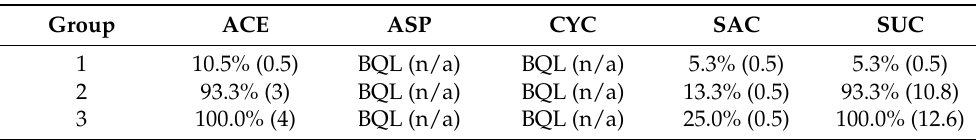
Table 2. Artificial sweetener detection frequencies (DFs) and detection ratios (DRs, in parenthesis) in the MMA